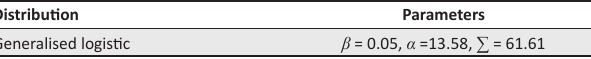
TABLE 6: Estimated parameters.